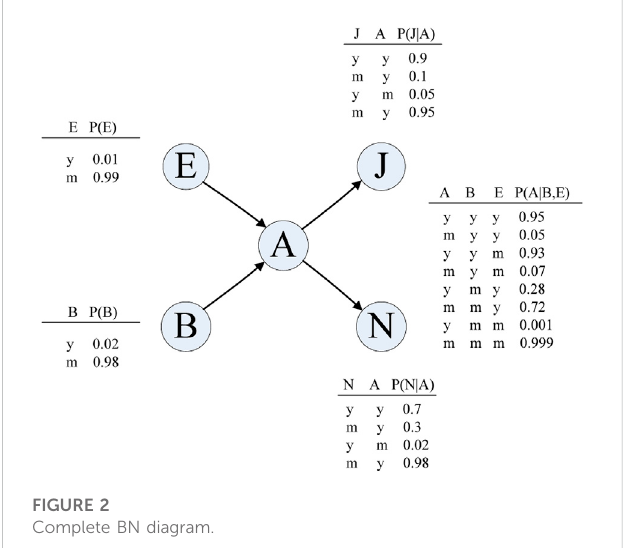
FIGURE 2 Complete BN